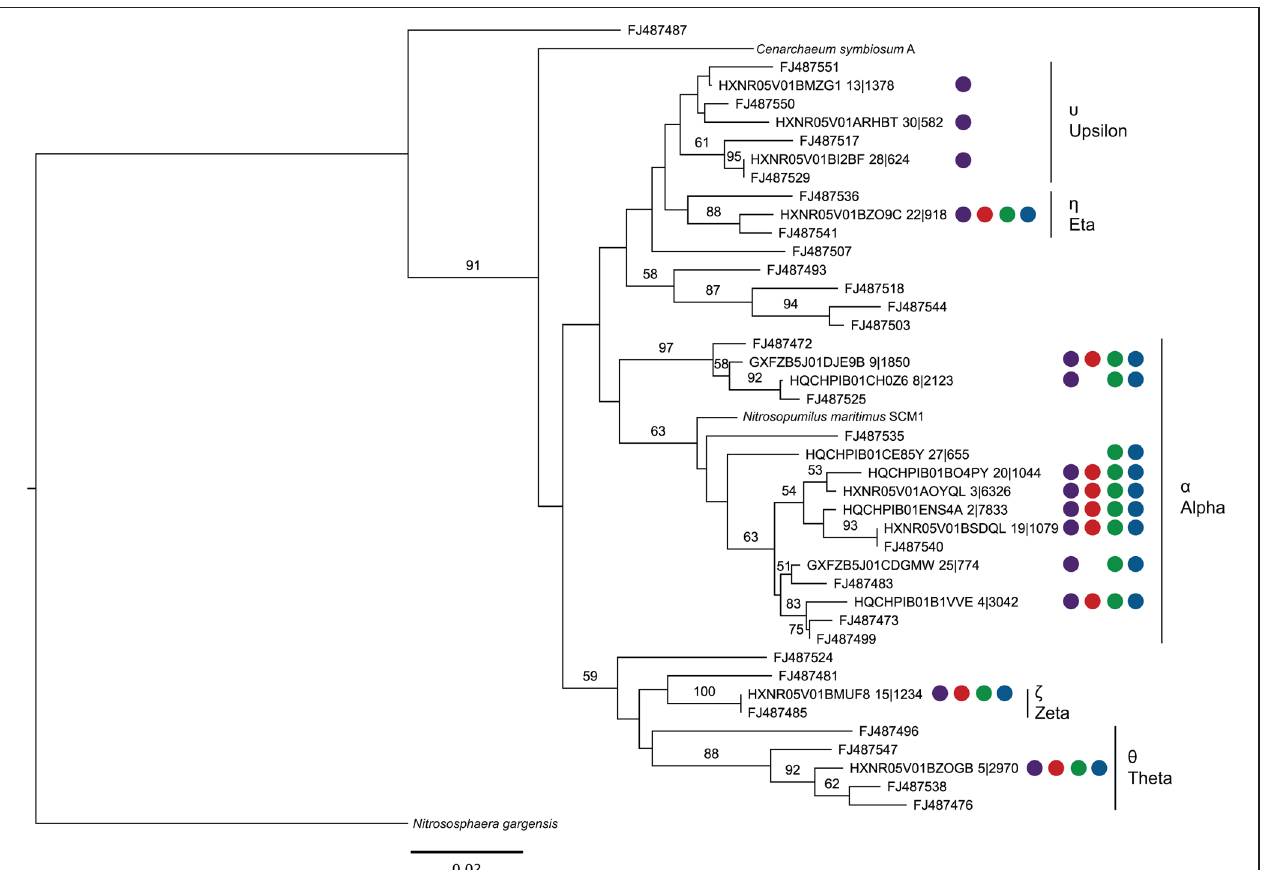
FIGURE 4 | Maximum likelihood phylogenetic tree constructed using 16S rRNA gene sequences (289bp) covering the V4 hypervariable region from representatives of each OTU putatively assigned as belonging to the Thaumarchaea MG-1 group (Sequence ID OTU No.|No. of total sequences assigned to OTU), sequences from Durbin and Teske (2010)